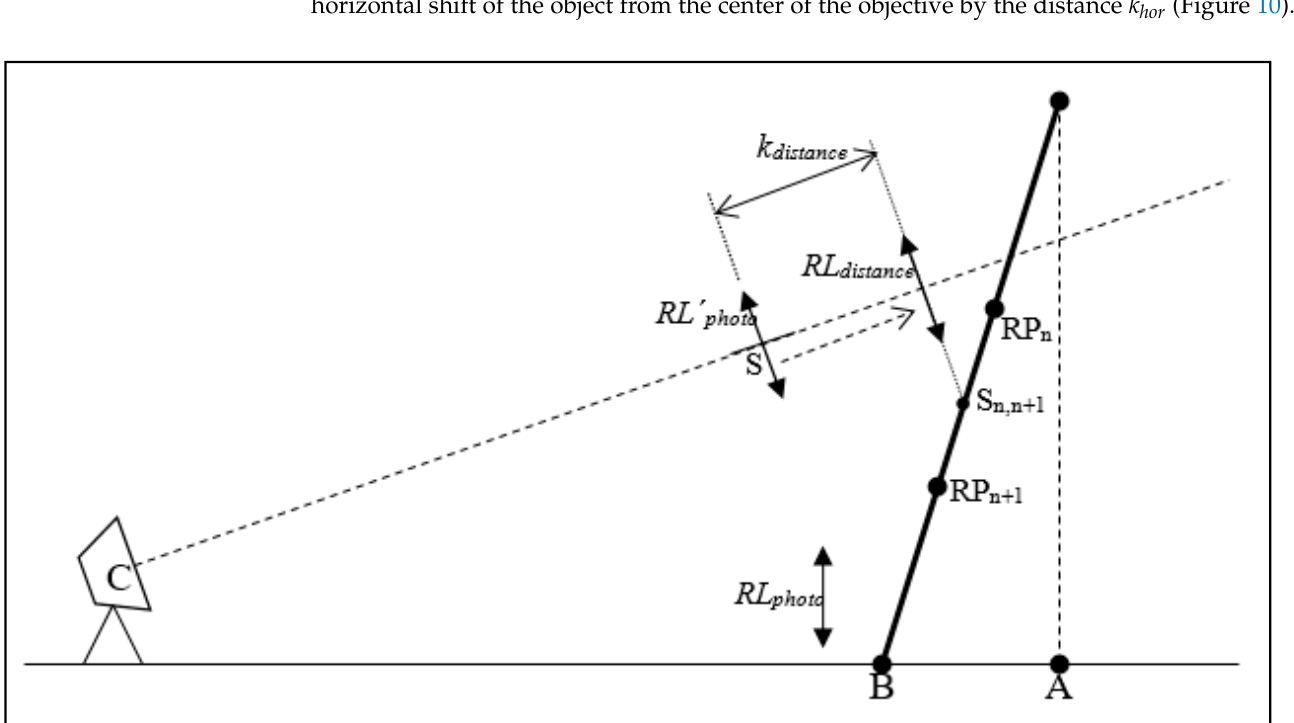
Figure 9. Correction of reference length in the distance (source: The authors of this article). Appl. Sci. 2021 , 11 , x FOR PEER REVIEW